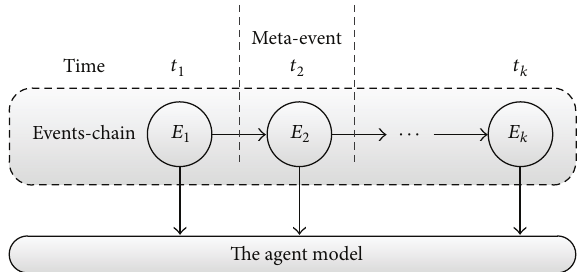
Figure 2: The events-chain model of temporal successive events.